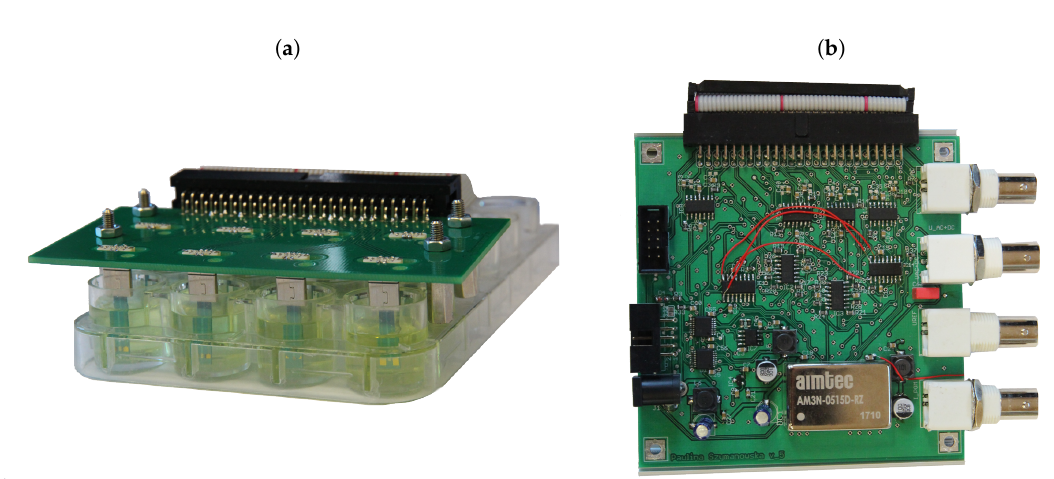
Figure 4. Measurement system: ( a ) eight-channel measurement head with sensors placed vertically in 24-well titrate plate and ( b ) eight-channel potentiostat.